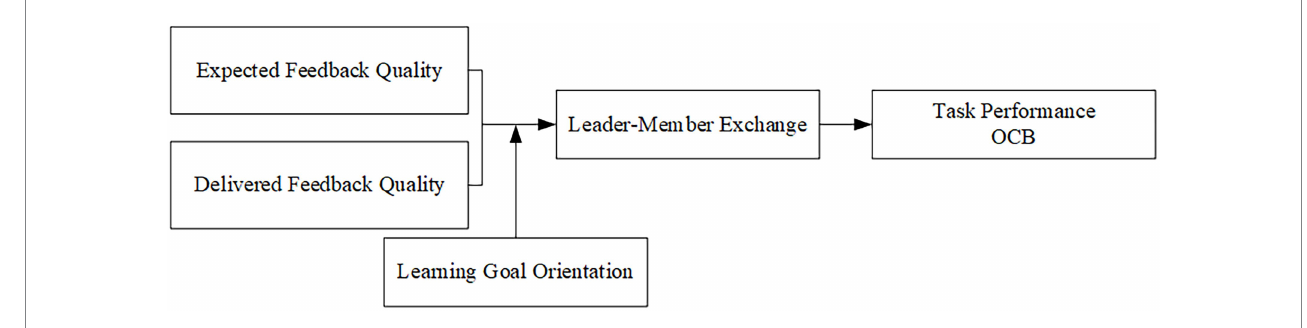
FIGURE 1 Hypothesized research